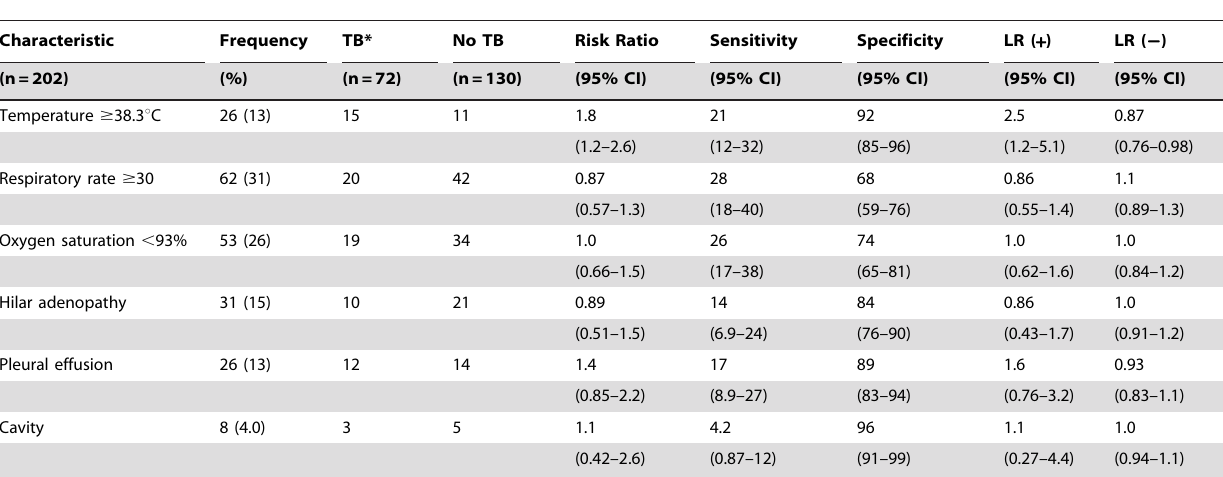
Table 3. Diagnostic performance of clinical and radiographic characteristics with high specificity for tuberculosis.